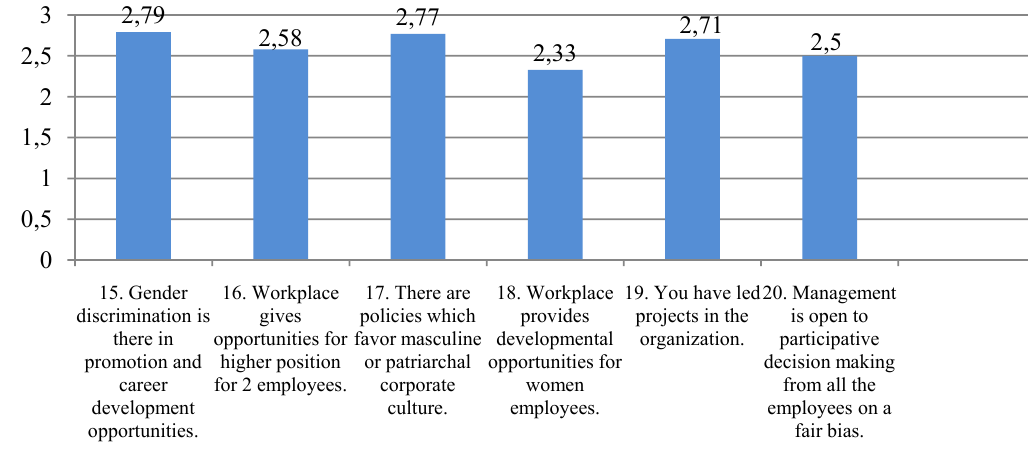
Fig. 3. Obstacles to gender diversity